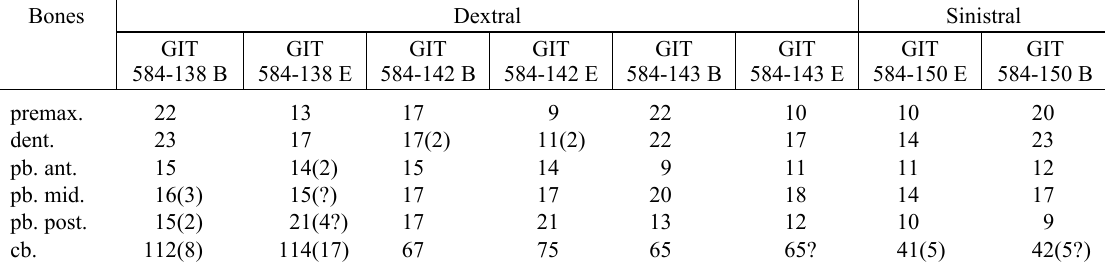
Table 2. Number of teeth on jaws and pharyngeal tooth plates of the European flounder Platichthys flesus trachurus . The counts of tooth sockets or notches are given in parentheses. Abbreviations: pb., pharyngobranchial; cb., ceratobranchial; dent., dentary; premax., premaxilla; B, blind side; R, eye side; ant., anteriormost; mid., middle; post.,